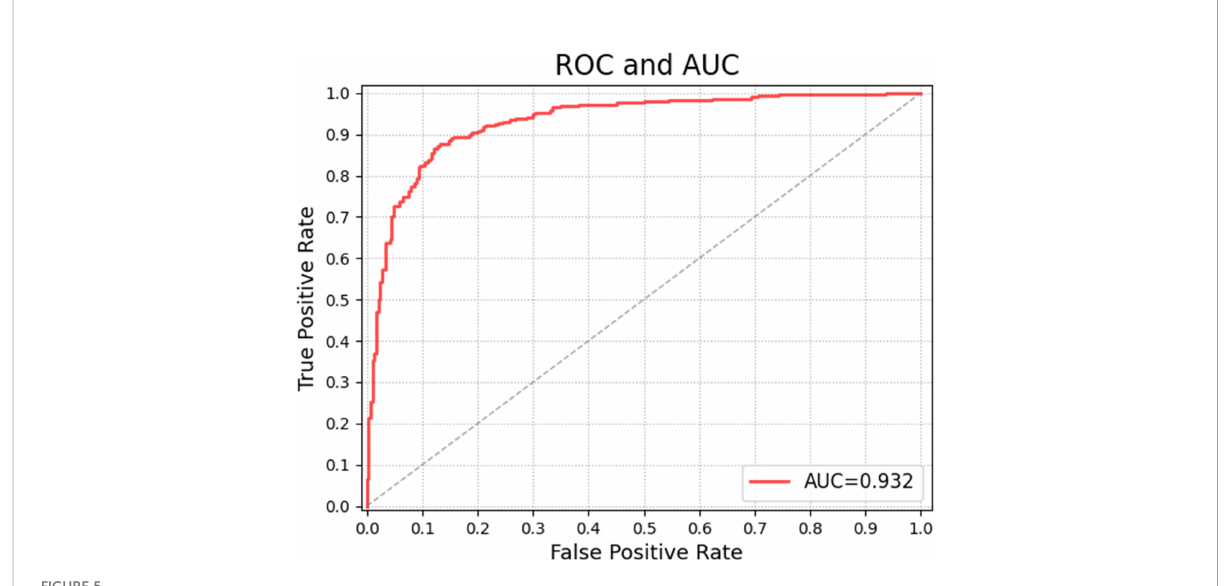
FIGURE 5 ROC curve of the proposed model on unbalanced data set.